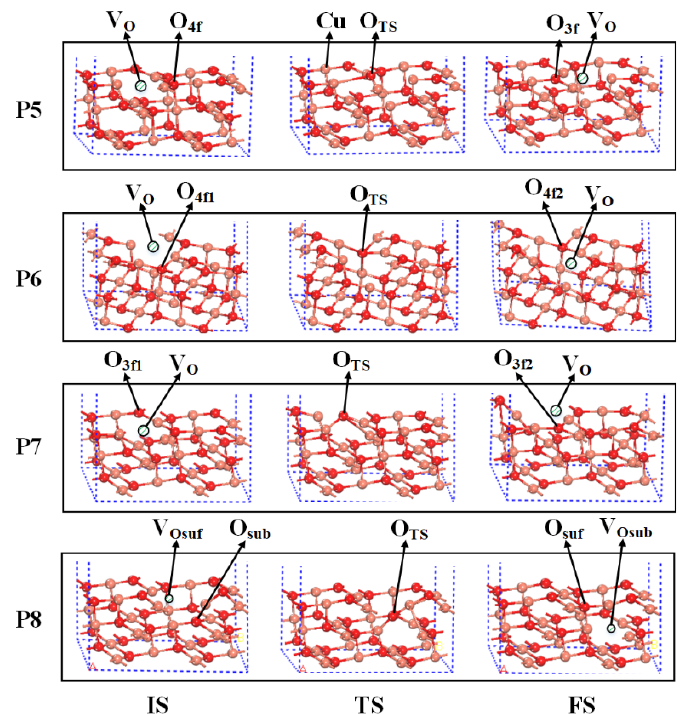
Figure 8. The initial state (IS), transition state (TS), and final state (FS) structures for the O anion diffusion processes in different pathways on the CuO(111) surface. The salmon pink and red spheres denote Cu and O atoms, respectively.